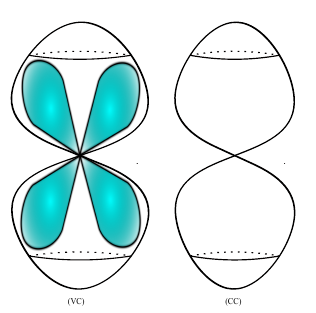
Figure 21. TI read by VC and CC at SW.